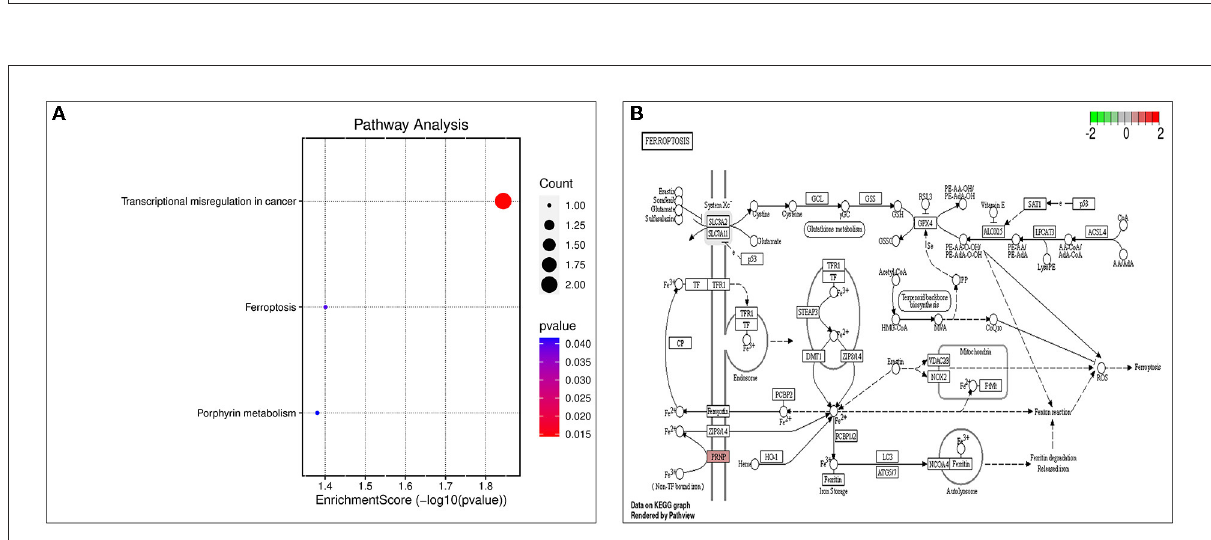
FIGURE5 Results of KEGG enrichment analysis. (A) KEGG enrichment analysis bubble chart; (B) ferroptosis signaling